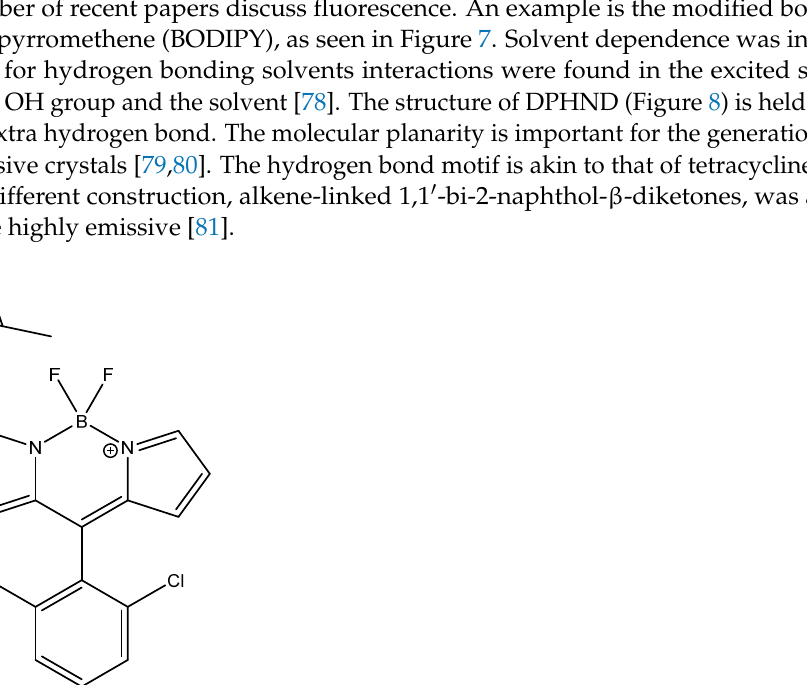
Figure 6. Enolic structure of 1,3-bis(4(10H-phenoxazin-10-yl)phenyl)3-hydroxyprop-2-en-1-one (PXZDO). Taken from Ref. [77] with permission from the American Chemical Society. The molecules are of the D-P-A-P-D type (D = donor, A = acceptor). As the core of molecules are β -diketones, they may exist both as enols and ketones.